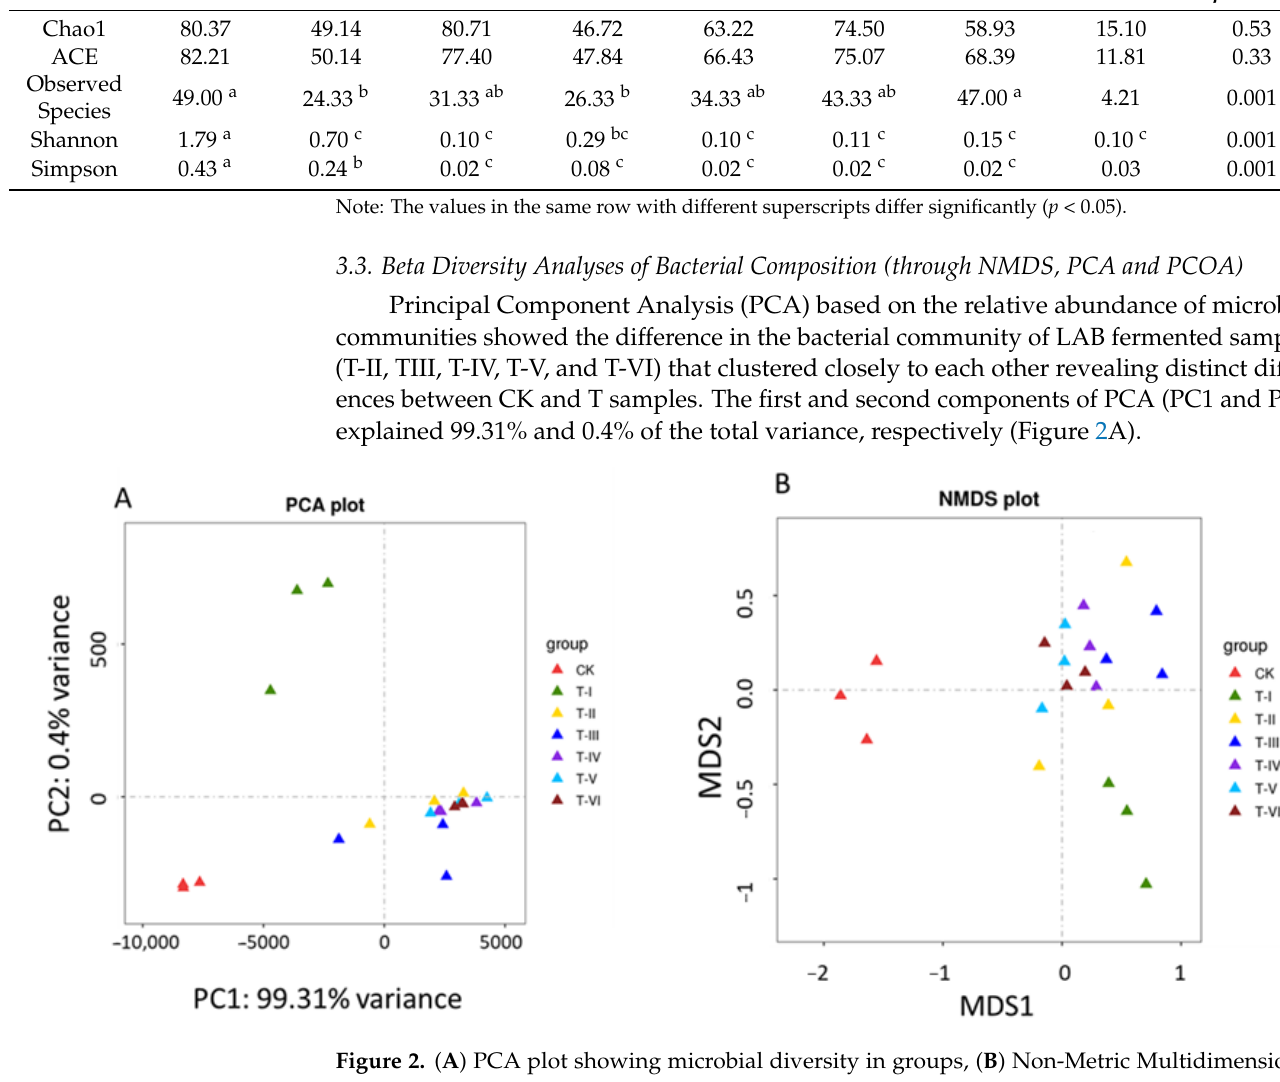
Table 2. Alpha diversity indices of microbial communities.